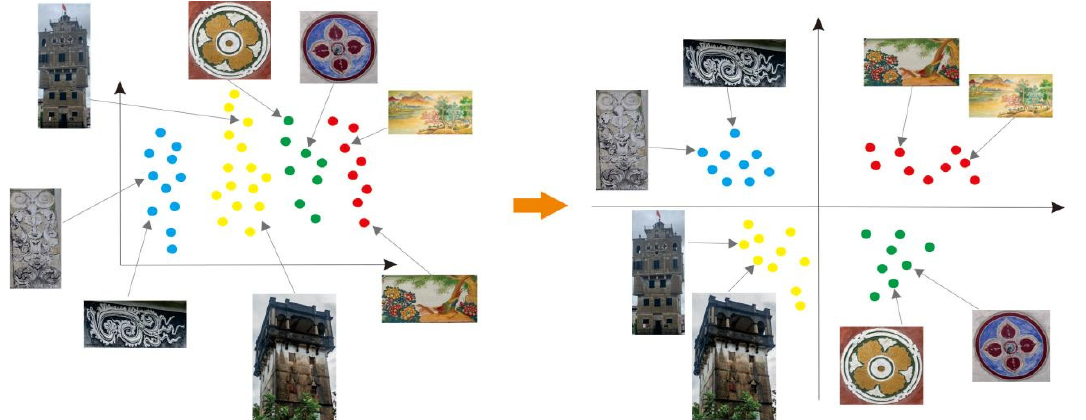
Figure 8. Schematic diagram of image feature classification space.